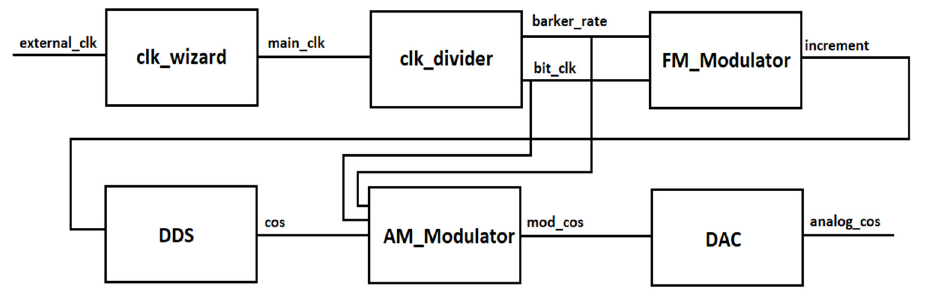
Figure 4. Functional block diagram of the master oscillator firmware on the SDRlab 122-16 board.